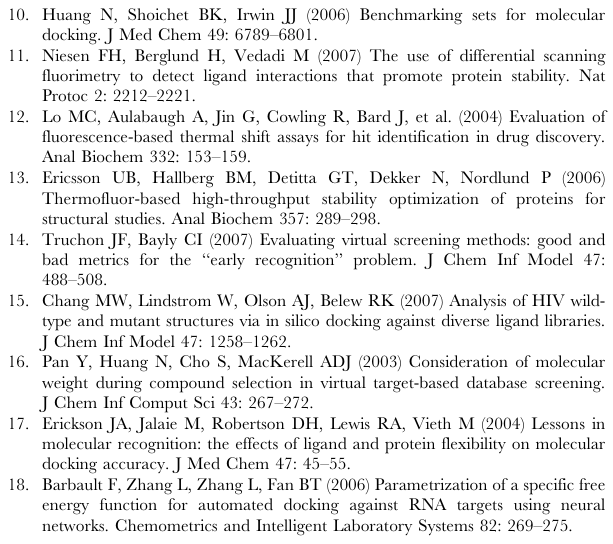
Table S1 DSF hits. NSC ID numbers for compounds designated as active in DSF screen.